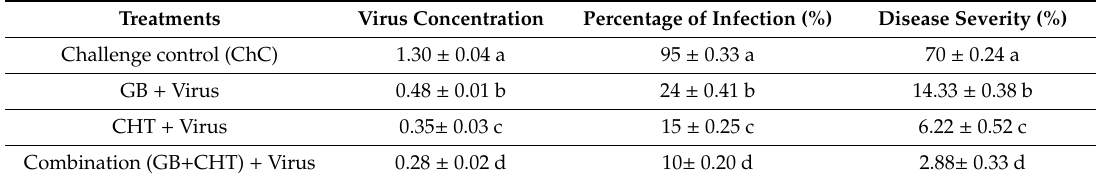
Table 1. Effect of foliar spray by glycine betaine (GB), chitosan (CHT) and combination (GB+CHT) on virus concentration, percentage of infection (%) and disease severity of cucumber plants leaves under CMV infection.